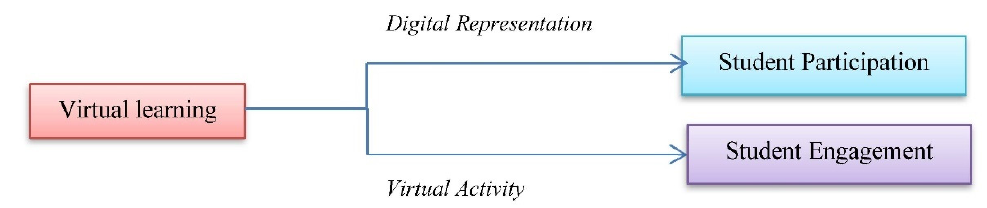
Figure 6. Key components of virtual learning. Source: Based on Al-Azzam et al. (2020), Johnson and Blitzer (2020), and Authors proposal (2022).